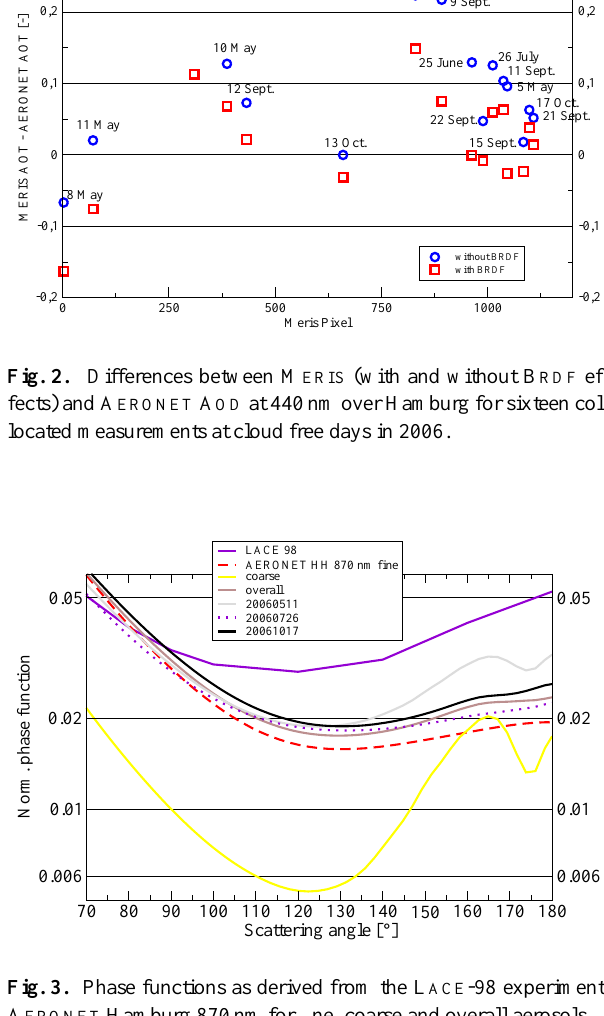
Fig. A2. Differences between M ERIS (with and without B RDF effects) and A ERONET A OD at 440 nm over Hamburg for sixteen collocated measurements at cloud free days in 2006.